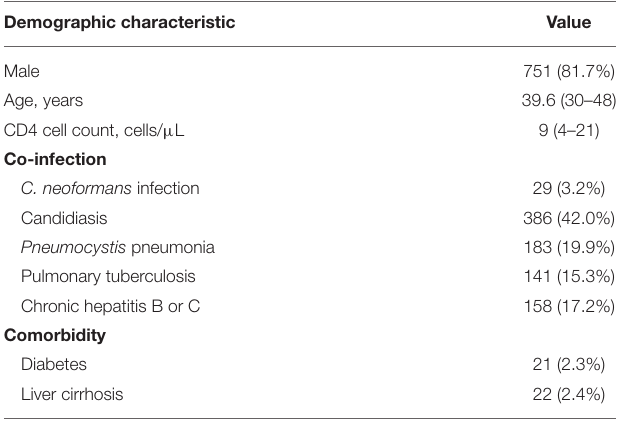
TABLE 1 | Demographic and clinical features of 919 HIV-infected patients with